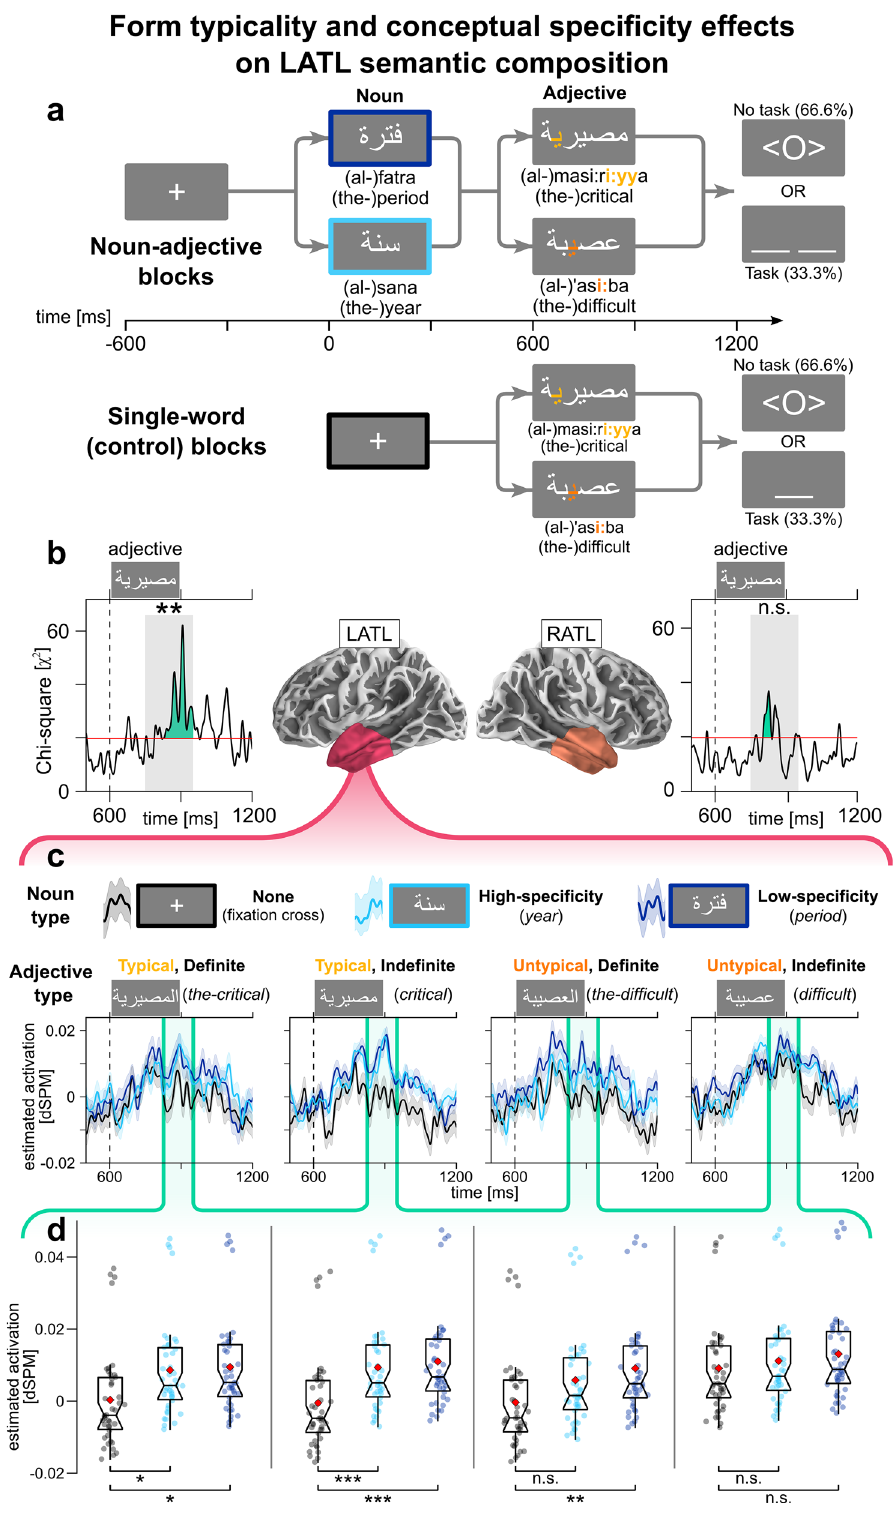
Figure 5. Semantic composition analyses and LATL effects of form typicality and conceptual specificity. ( a ) Trial structure outlining noun conceptual-specificity and adjectival form typicality manipulations. Highlighted letters on adjectives indicate form typicality (yellow) and untypicality (orange) cues. ( b ) Model comparison results assessing the effect of noun type, adjectival form typicality, adjectival definiteness, and all possible interactions in the adjective window (750–950 ms), in the LATL (left) and RATL (right). Red lines indicate cluster-forming threshold. ( c ) Model-based estimated marginal means of LATL activation per condition. Conditions are separated by adjective form typicality and definiteness. Green shape demarcates extent of LATL cluster in ( a ). ( d ) Estimated marginal means of LATL activation within cluster per condition. Significance bars show corrected pairwise